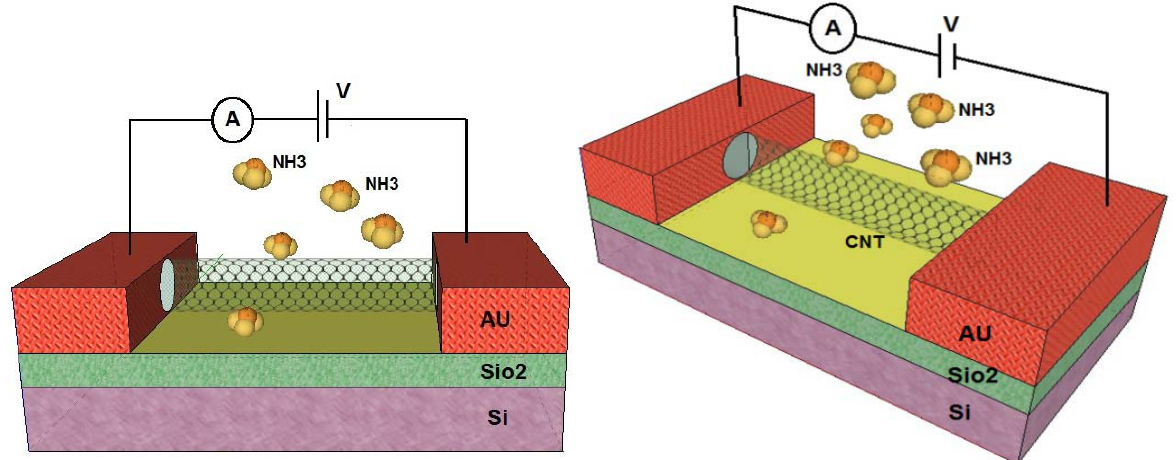
Figure 2. FET-based structure for a gas sensor with a carbon nanotube channel.